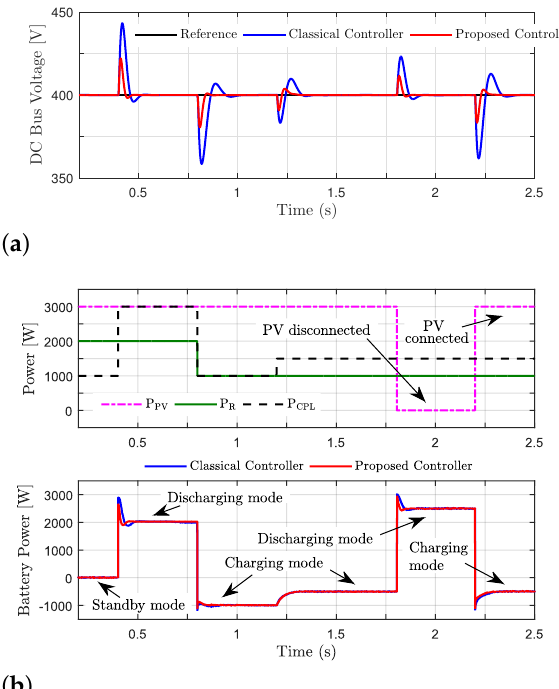
Figure 9. Simulated Case I: ( a ) dc–bus voltage; ( b ) microgrid power flow time–domain.